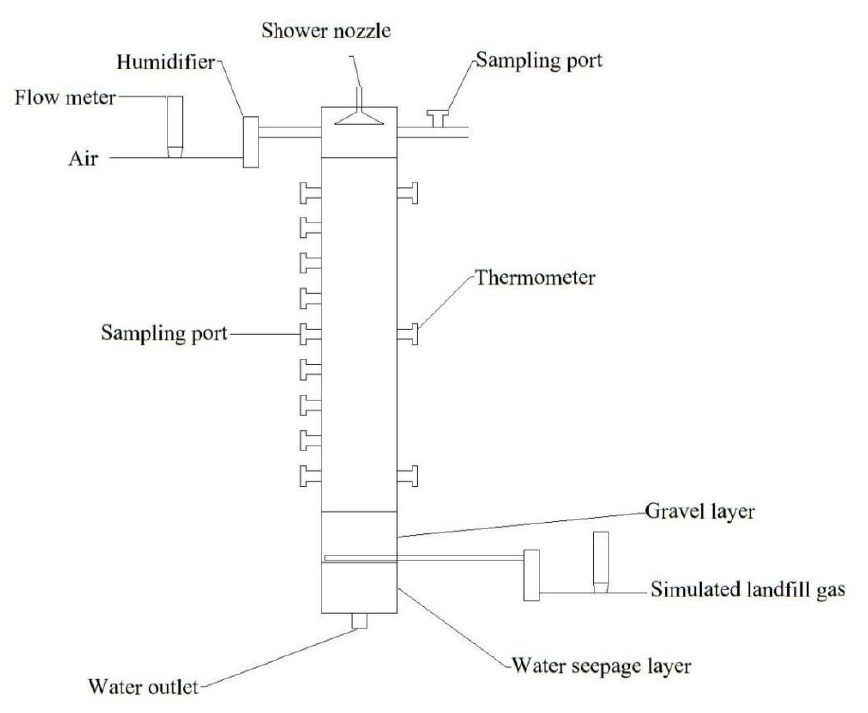
Figure 2. Schematic setup of the column experiment.